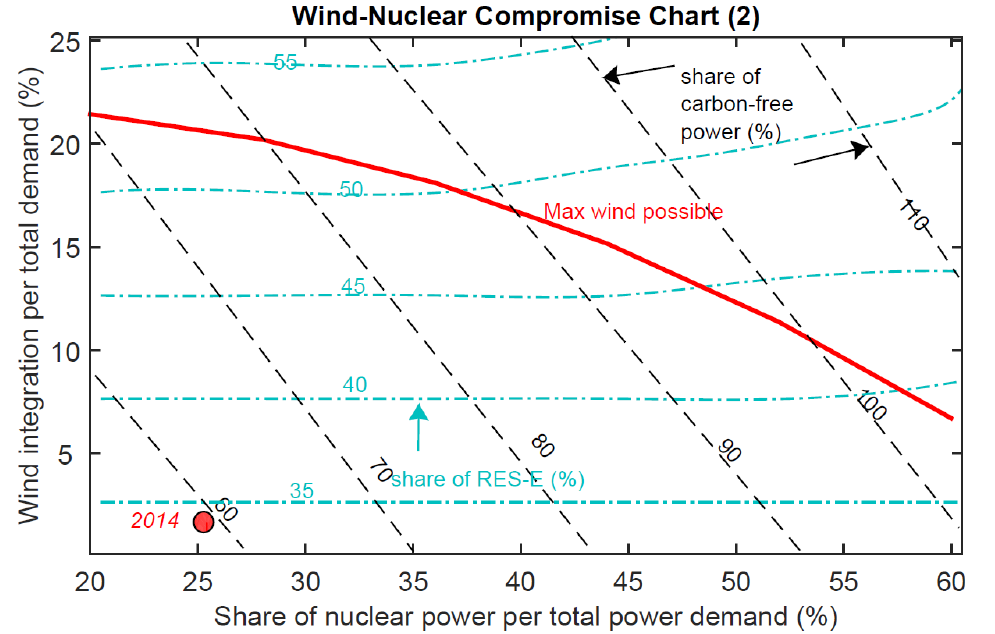
Figure C1. Optimization map of wind-nuclear compromise for evaluating the share of carbon-free power production (black dashes) and RES-E (blue dashes), compared with maximum possible wind (red curve) and today’s conditions (red circles). The ratios are per total power demand (see Section 4.4 for